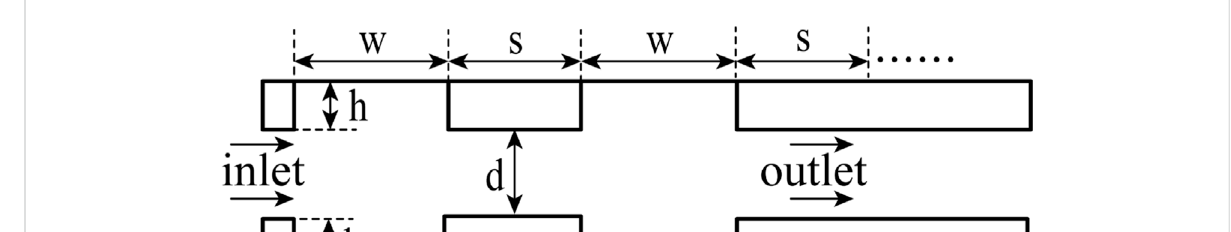
FIGURE 5 BBHE schematic